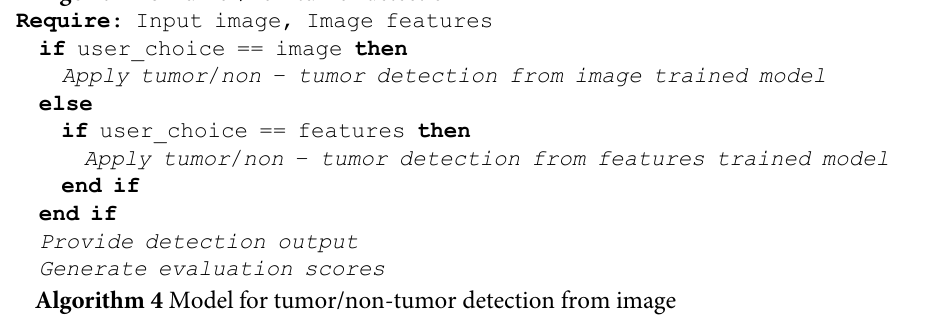
Algorithm 3 Tumor/non-tumor detection